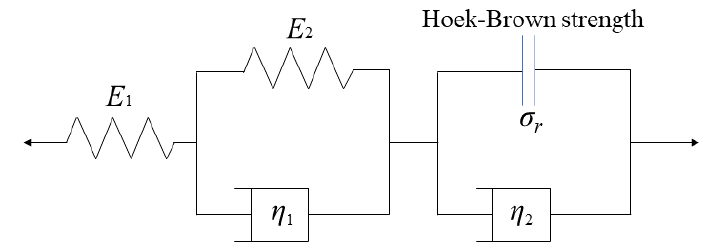
Figure 3. Combination of the creep elements for rock mass.